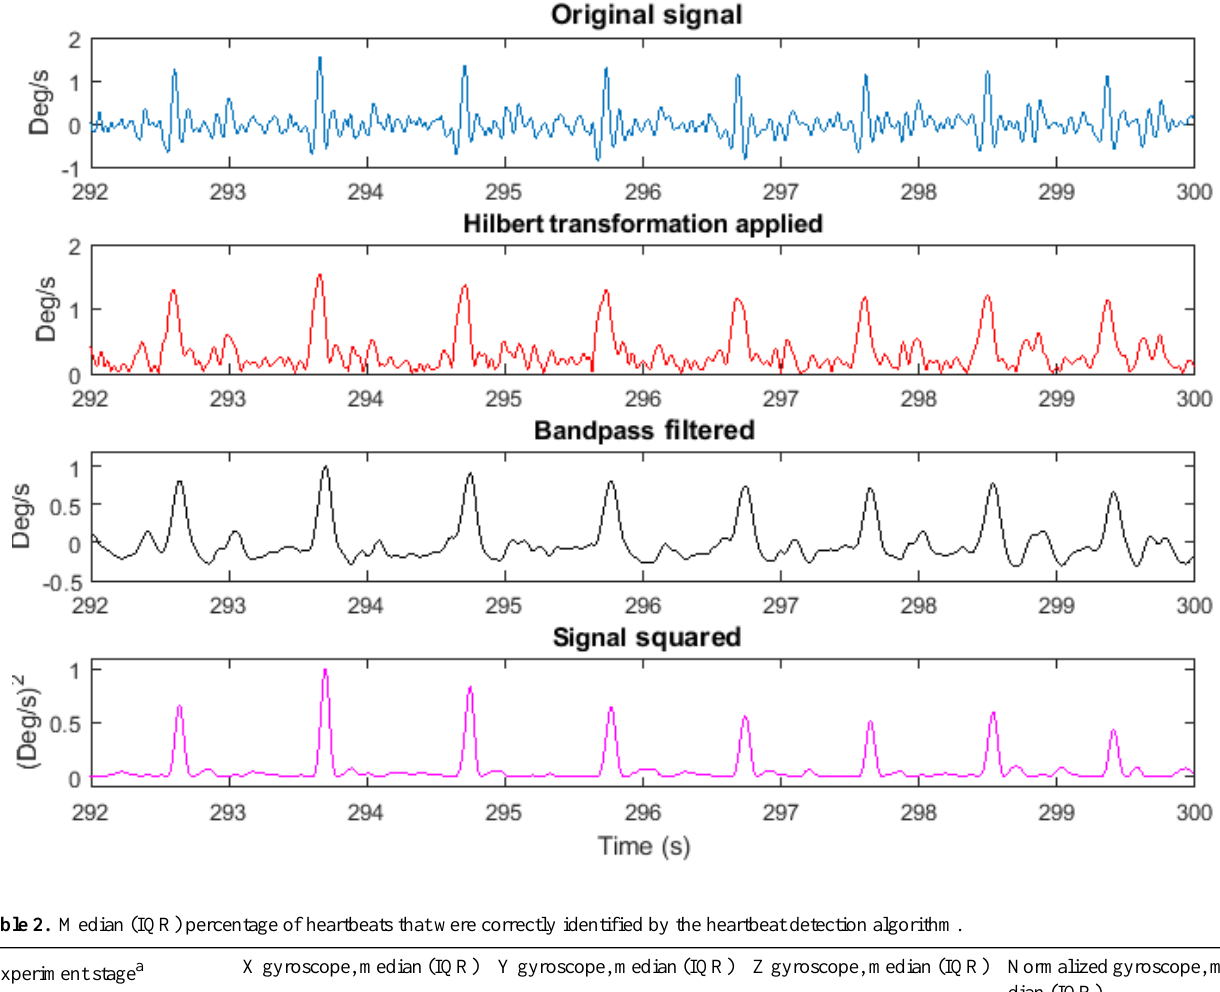
Normalized gyroscope,